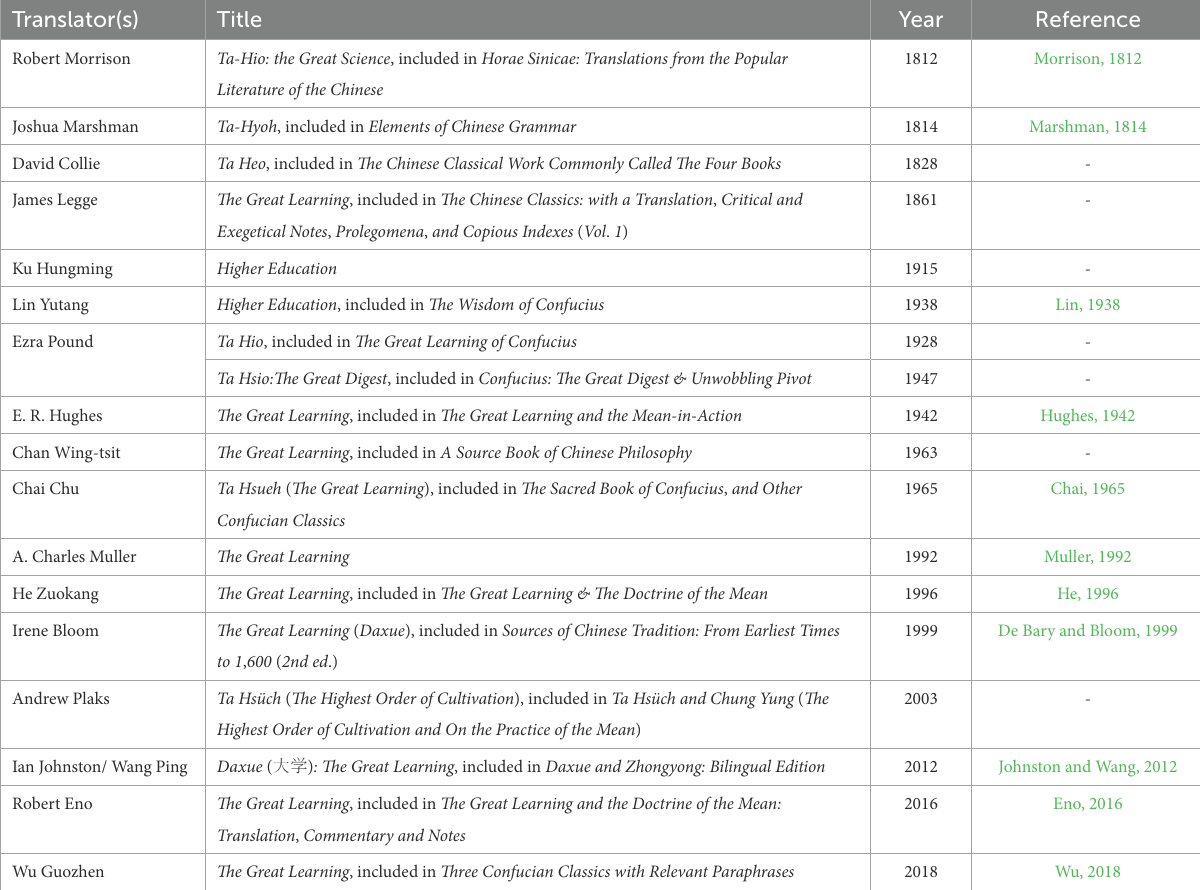
TABLE 1 Eighteen English translations of Daxue (including the translator’s name, book title, and publication year).